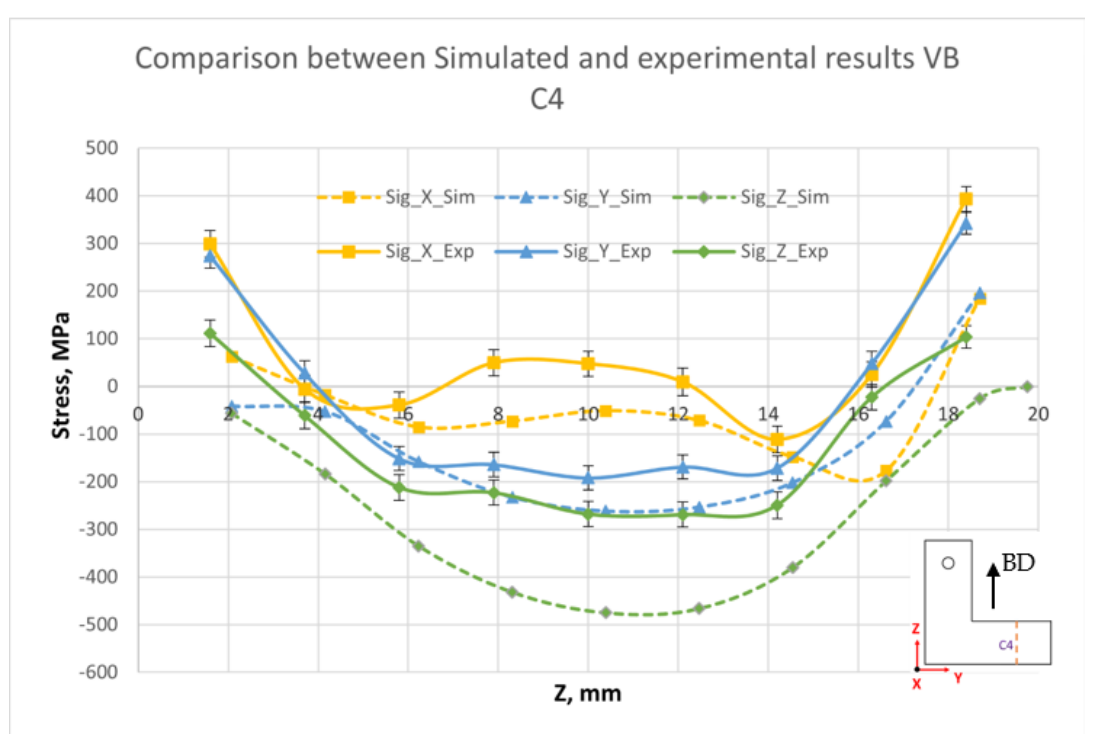
Figure 17. Comparison between experiment and simulation results for VB sample cross-section C4.